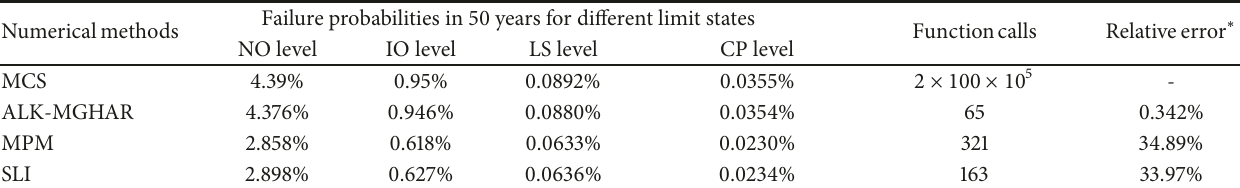
Table 6: Results with N 1 =3 and N 2 =4 by different